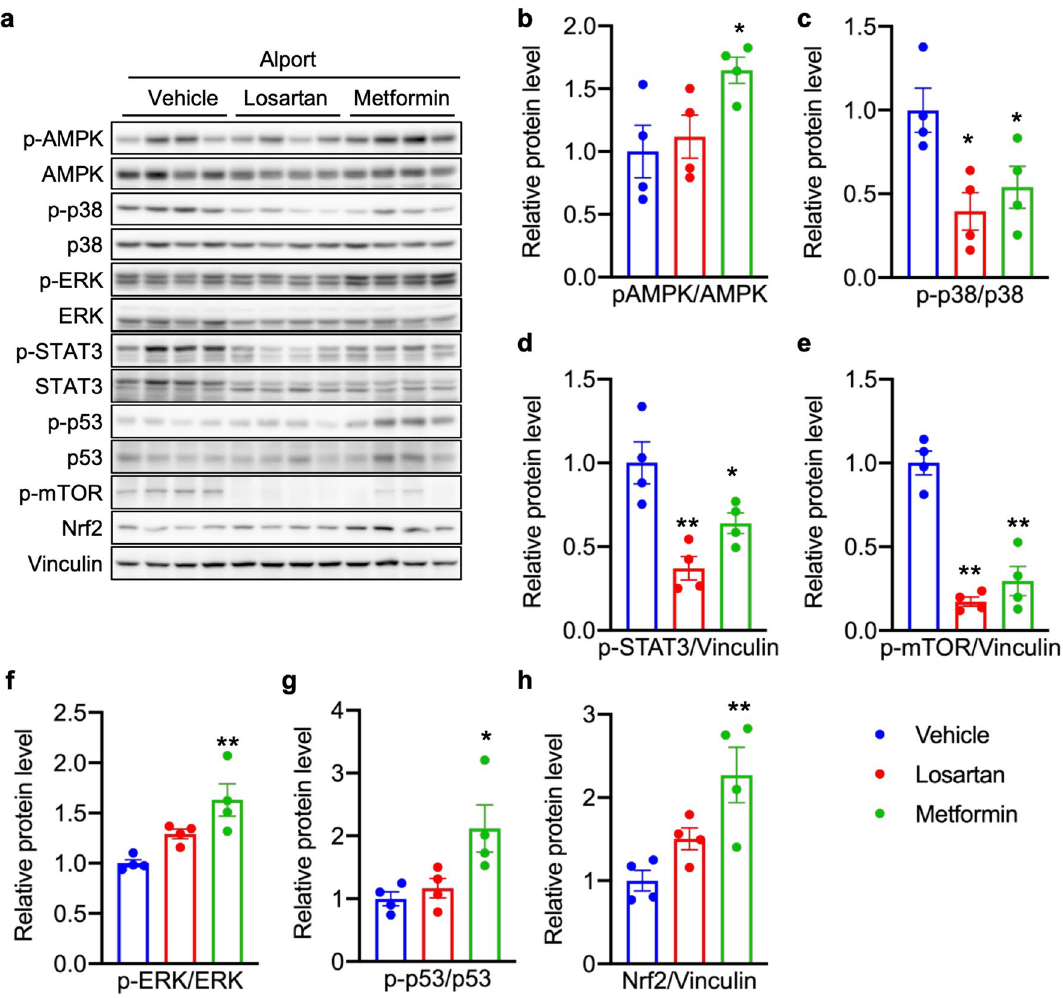
Figure 3. Metformin regulates various intracellular signaling pathways in kidney of Col4a5 G5X Alport syndrome mice. ( a ) Whole kidney lysates were analyzed by immunoblotting. The full-length blots are presented in Supplementary Fig. S12. ( b – h ) The relative amount of proteins was quantified. Losartan or metformin decreased the level of ( c ) phospho-p38, ( d ) phospho-STAT3, ( e ) phospho-mTOR. Only metformin increased the level of ( a ) phospho-AMPK, ( f ) phospho-ERK, ( g ) phospho-p53 and ( h ) Nrf2. Data are expressed as the means ± S.E. (n = 4 per group). P values were assessed by Dunnett’s test (* P < 0.05, ** P < 0.01 vs